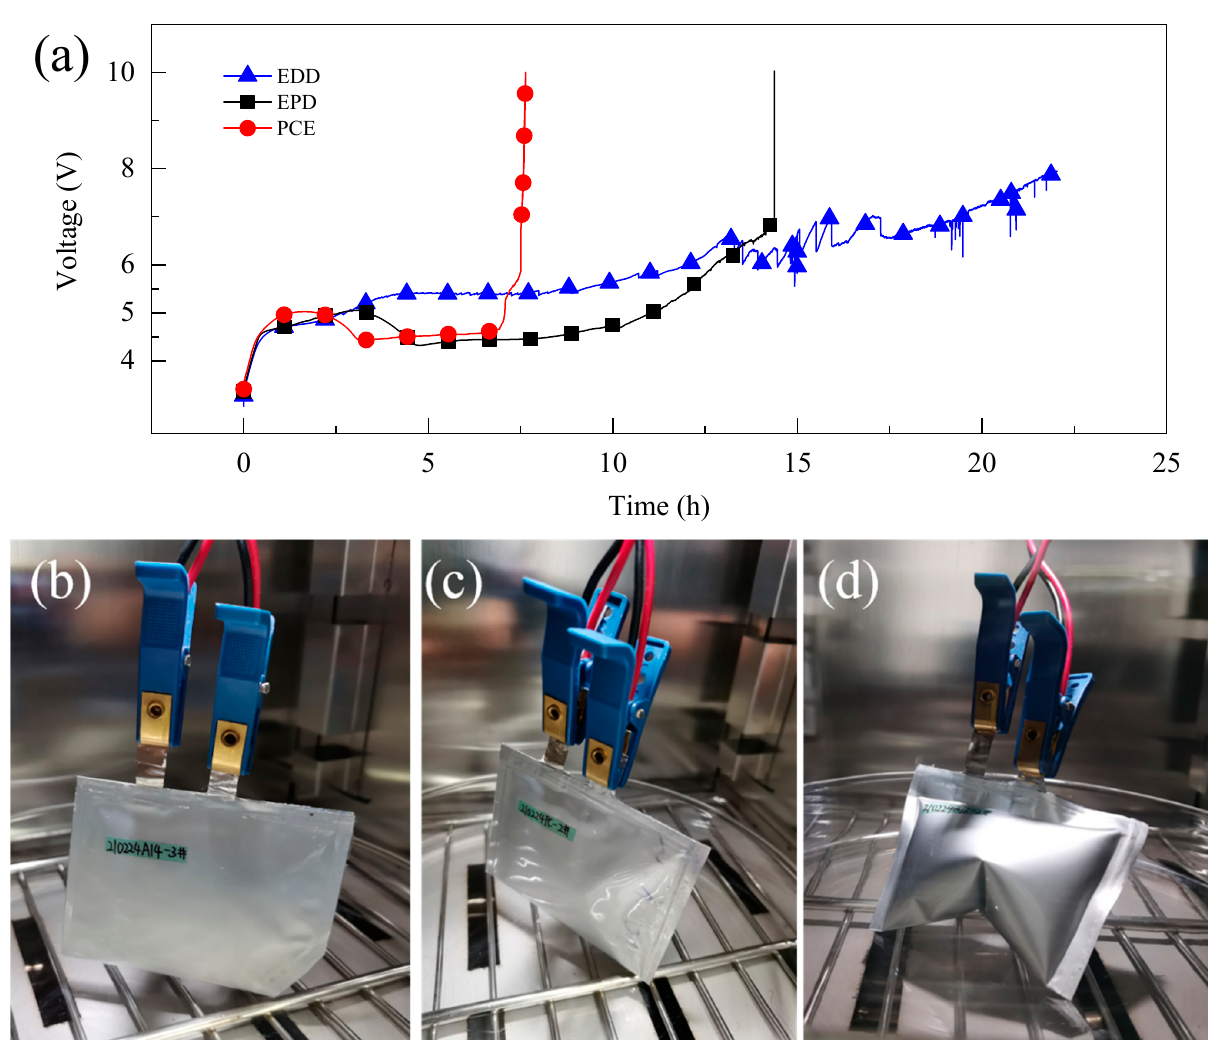
Figure 3. Overcharged to 10.0 V of AC//Li half ‐ cells: ( a ) voltage versus time profiles, and photos of the half ‐ cells after overcharging process with different electrolytes: ( b ) EPD, ( c ) PCE and ( d ) EDD.